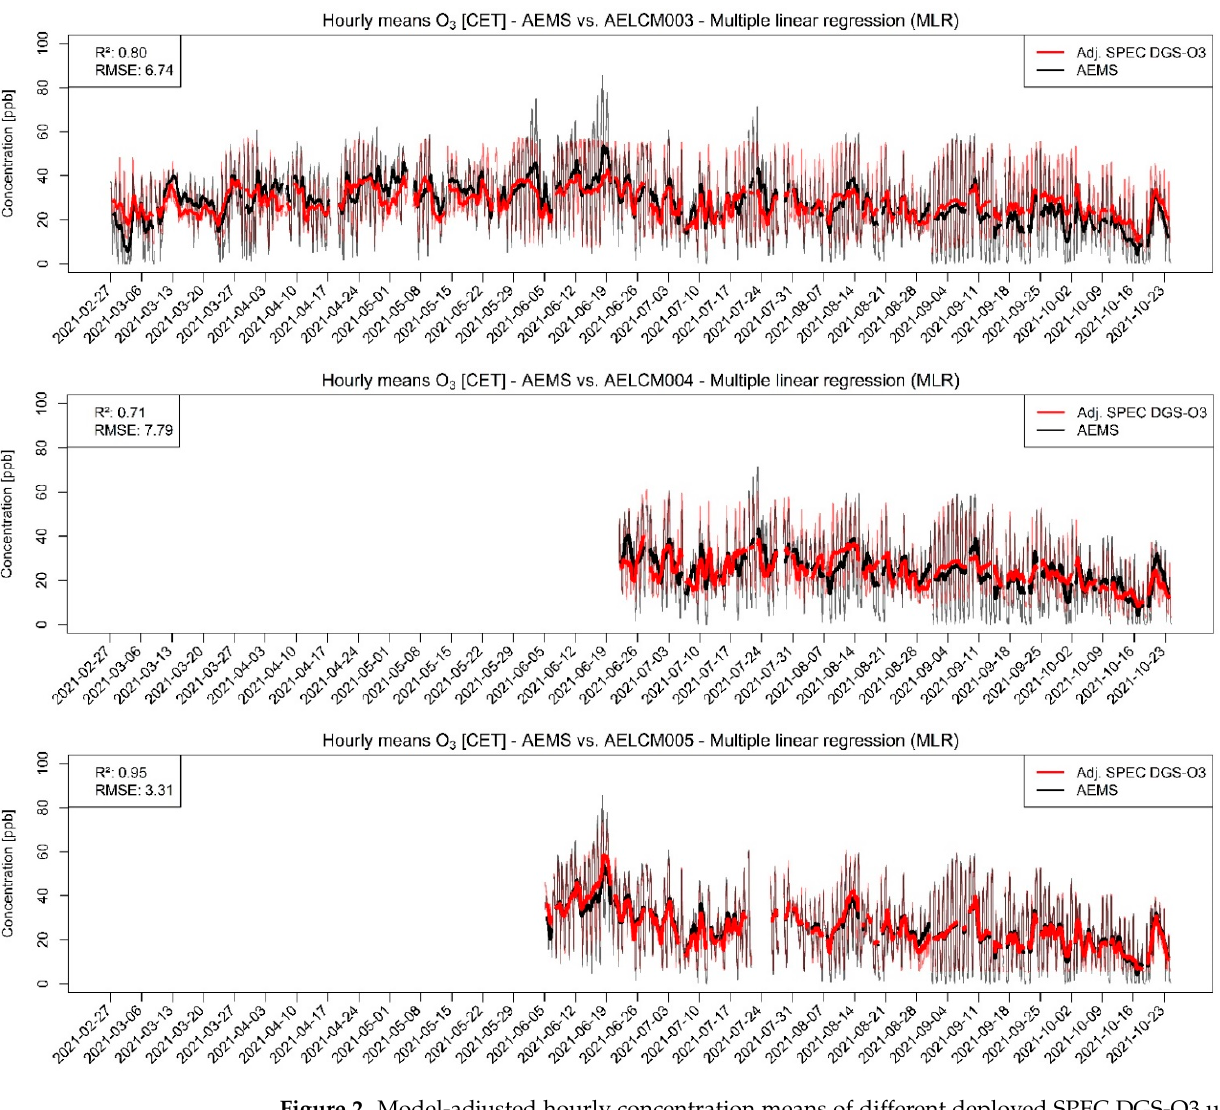
Figure 2. Model ‐ adjusted hourly concentration means of different deployed SPEC DGS ‐ O3 using multiple linear regression vs. hourly concentration means of reference measurements given by the AEMS for ambient O 3 in ppb. The RMSE is in ppb. For smoothing the hourly concentration means, a rolling 24 h average is used: ( Top ) SPEC DGS ‐ O3 deployed in AELCM003; ( Middle ) SPEC DGS ‐ O3 deployed in AELCM004; and ( Bottom ) SPEC DGS ‐ O3 deployed in AELCM005.